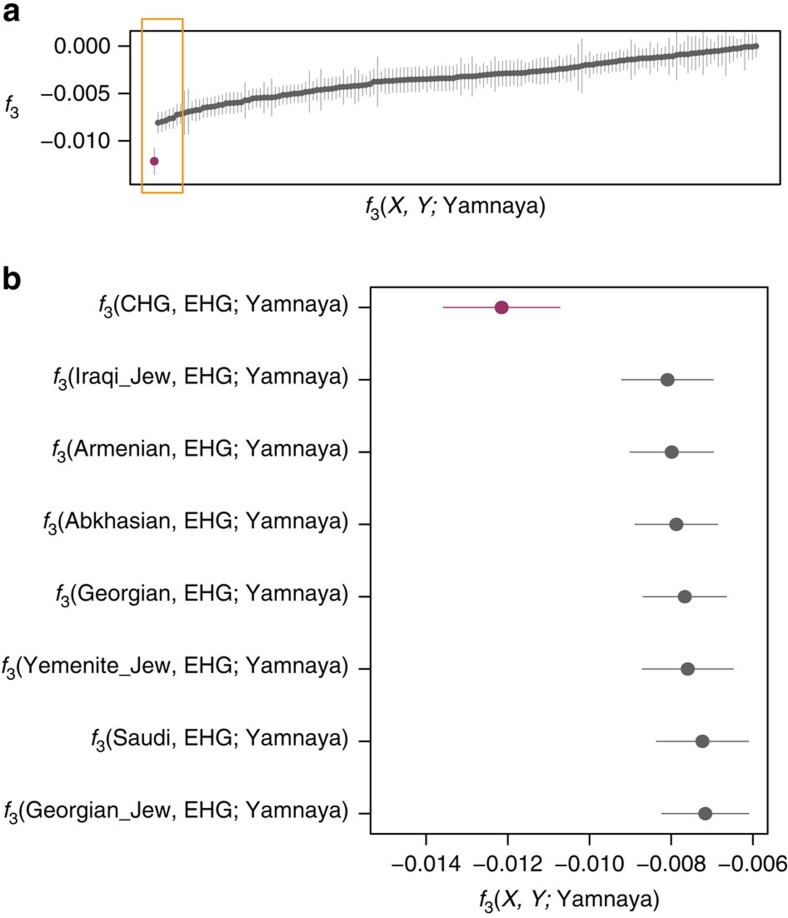
Lowest admixture f3-statistics of the form f3 (X, Y; Yamnaya).These statistics represent the Yamnaya as a mix of two populations with a more negative result signifying the more likely admixture event. (a). All negative statistics found for the test f3(X, Y; Yamnaya) with the most negative result f3(CHG, EHG; Yamnaya) highlighted in purple. Lines bisecting the points show the standard error. (b). The most significantly negative statistics which are highlighted by the yellow box in a. Greatest support is found for Yamnaya being a mix of Caucasus hunter-gatherers (CHG) and Russian hunter-gatherers who belong to an eastern extension of the WHG clade (EHG).